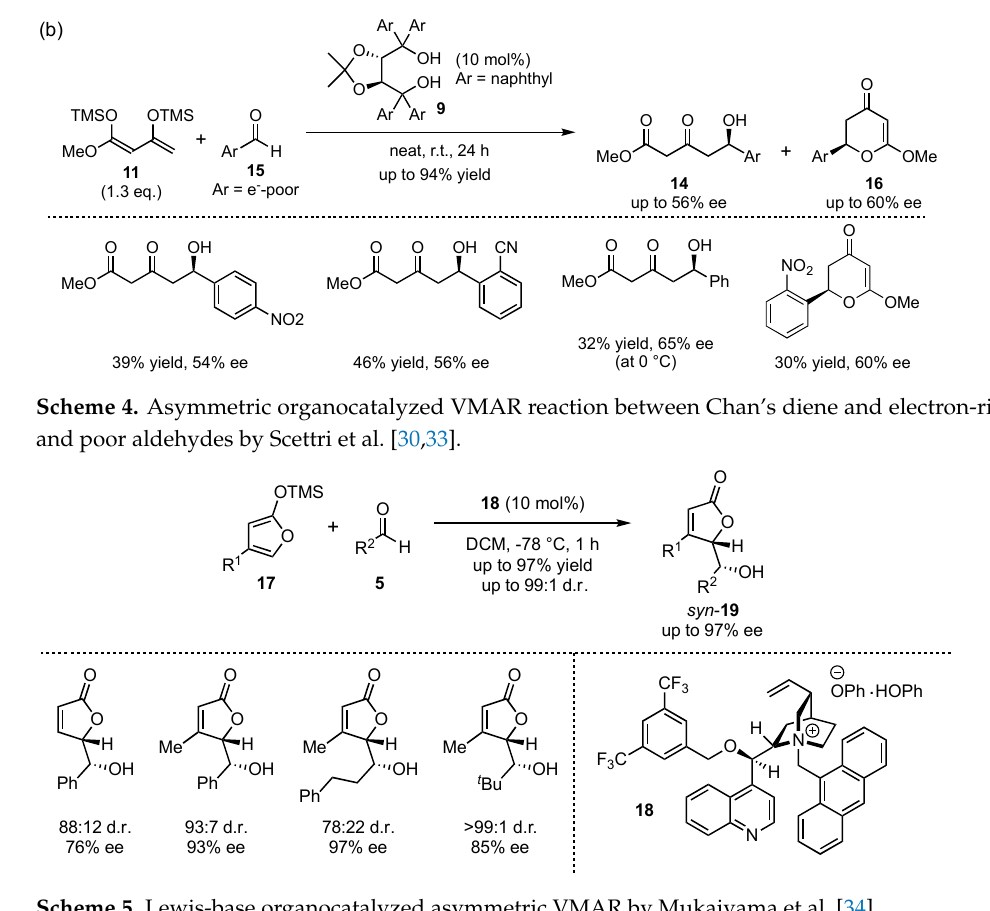
Scheme 5. Lewis-base organocatalyzed asymmetric VMAR by Mukaiyama et al. [34].